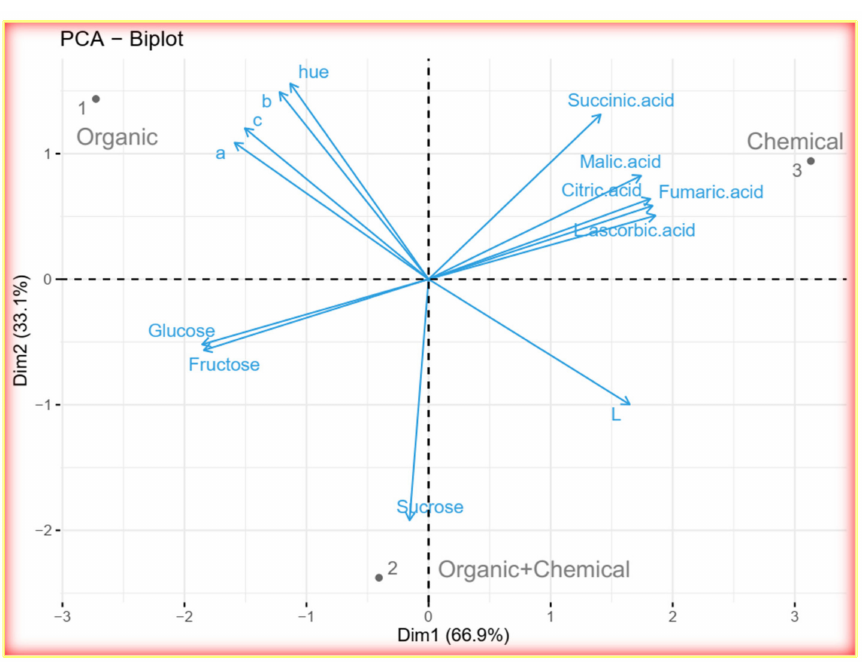
Figure 2. PCA-Biplot graph for organic acids, sugars, and color parameters of strawberry fruits as affected by different organic or chemical fertilizer treatments, grouping for cultivars (up), and grouping for fertilizers